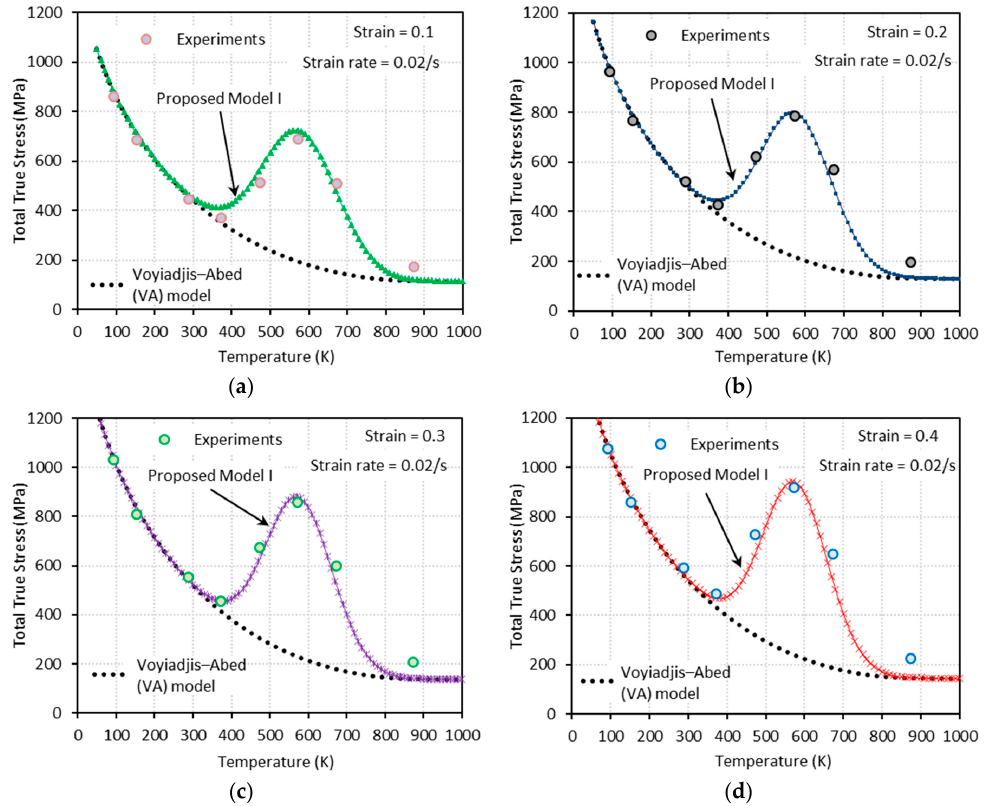
Figure 10. Comparisons between model predictions from the VA and proposed model I and Figure10. ComparisonsbetweenmodelpredictionsfromtheVAandproposedmodelIandexperimental experimental data from [1] on the total true stress versus temperature responses at ( a ) (cid:2013) = 0.1 , ( b ) data from [1] on the total true stress versus temperature responses at ( a ) ε = 0.1, ( b ) ε = 0.2, ( c ) ε = 0.3. . ε = (cid:2013) = 0.2 , ( c ) (cid:2013) = 0.3 . and ( d ) (cid:2013) = 0.4 . Quasi-static loading with (cid:2013)(cid:4662) = 0.02 (cid:1871) (cid:2879)(cid:2869) is applied. and ( d ) ε = 0.4. Quasi-static loading with 0.02 s − 1 is